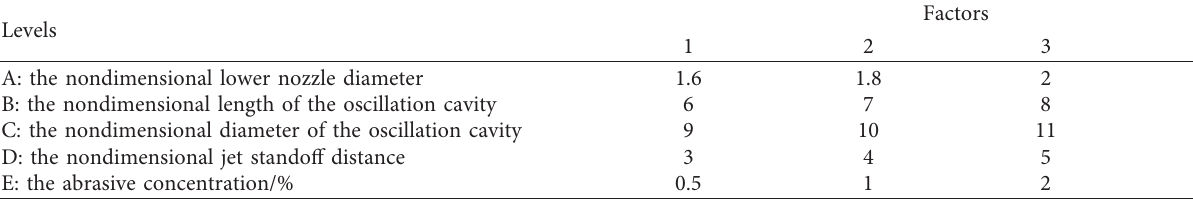
Table 1: The factors and levels of the orthogonal experiment.